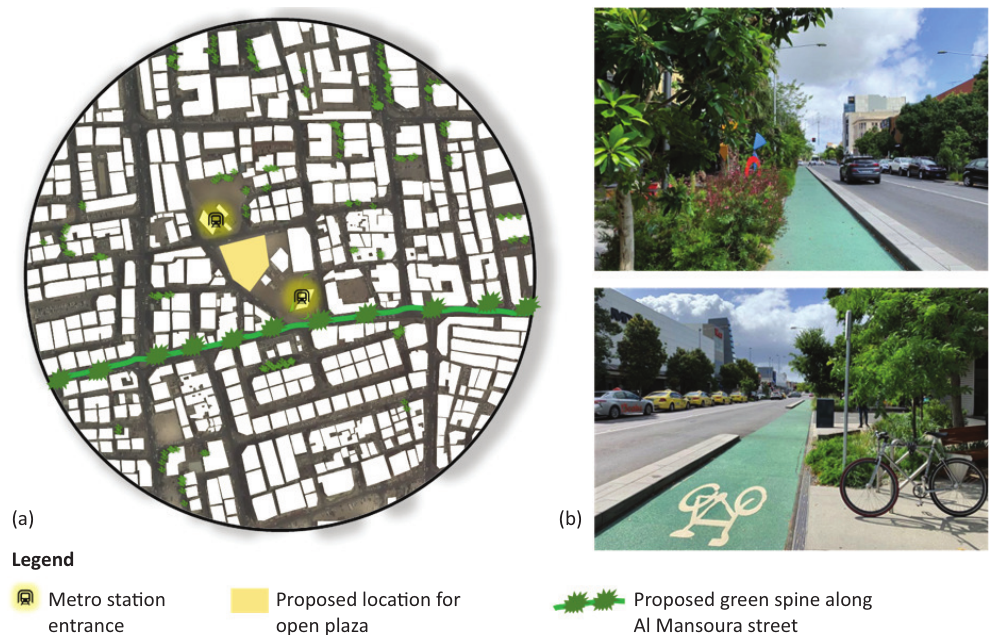
Figure 11. Proposed projects near the metro station: (a) Proposed green spine along the main street, (b) envisaged fea‐ tures of the green spine. Sources: (a) Authors’ work; (b) Mills